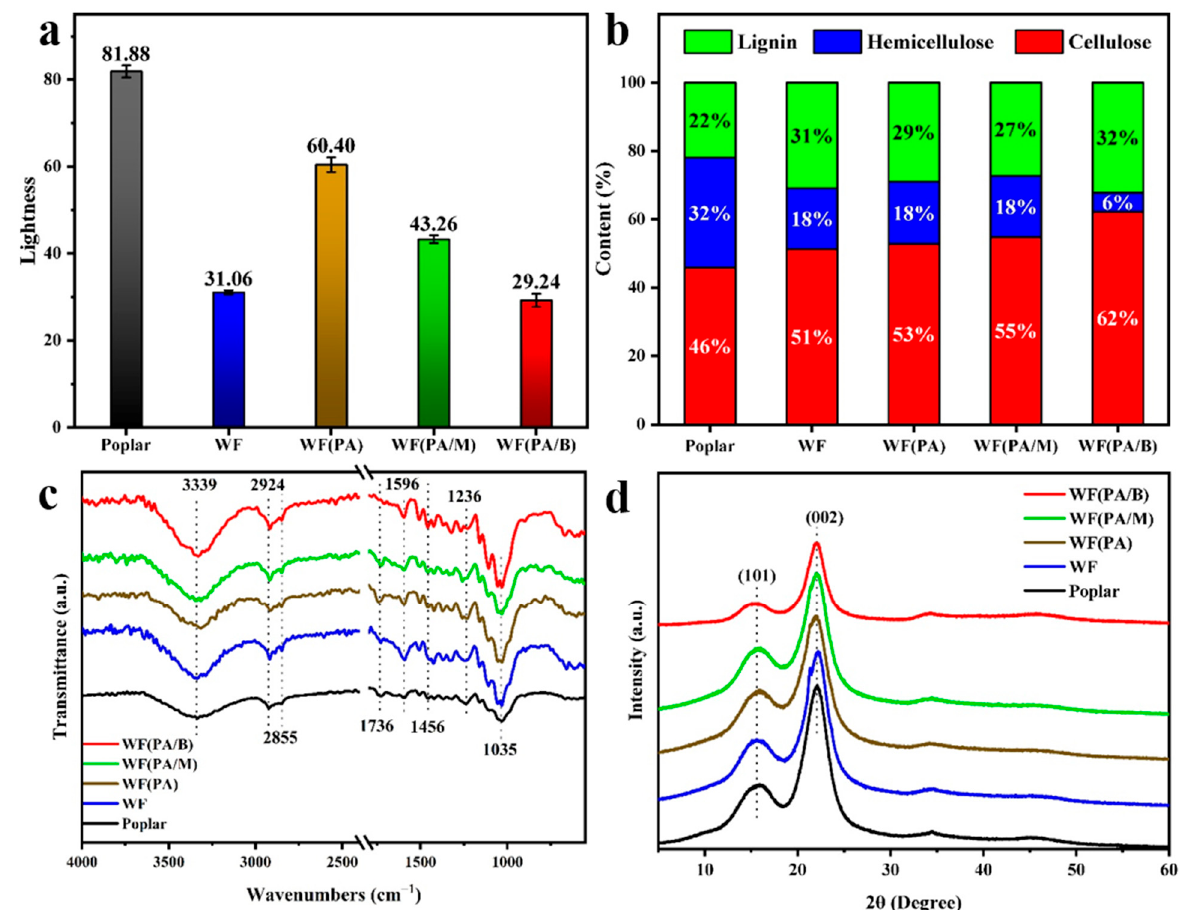
Figure 6. ( a ) Lightness contrast of poplar biocomposites. ( b ) Chemical composition of poplar and biocomposites. ( c ) ATR FT-IR spectra of multiple biocomposites products and raw material. ( d ) XRD patterns of multiple biocomposite products and raw materials.